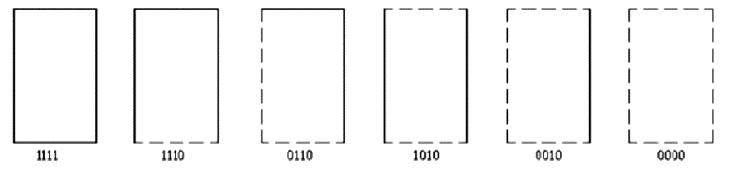
Figure 7. Arrangement of wind protection screens.